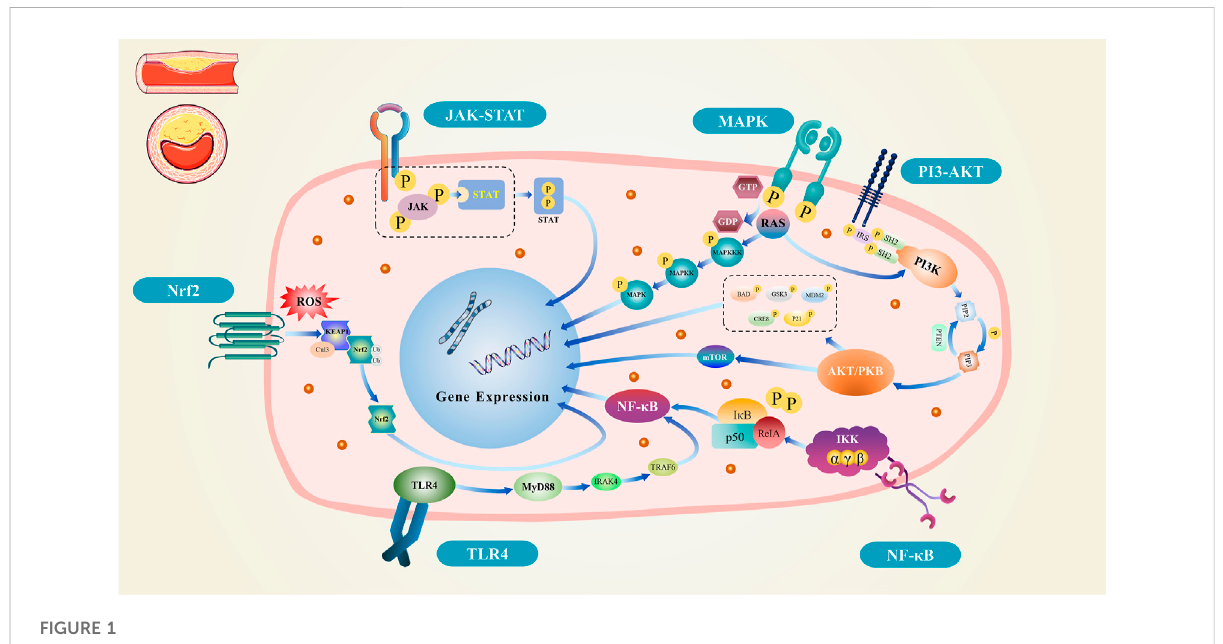
FIGURE 1 Schematic diagram of the signal